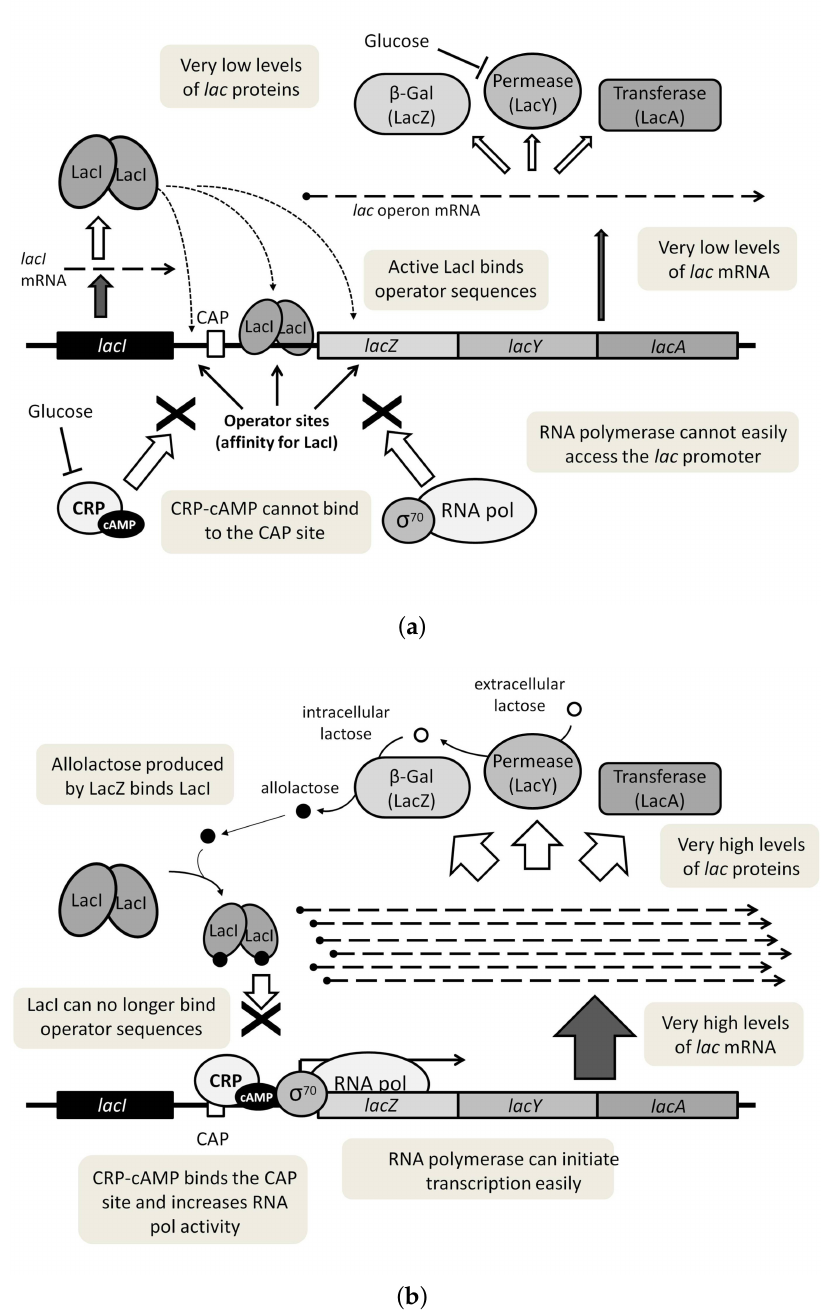
Figure 1. ( a ) The lac operon OFF state is characterized by transcription of low mRNA levels, due to the strong binding of the LacI repressor to operator sequences. ( b ) The lac operon ON state involves transcription of high mRNA levels and increased production of the different lac